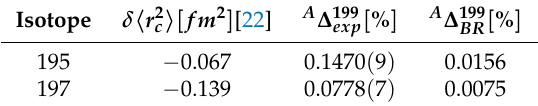
Table 10. Experimental HFA for I = 1/2 isotopes compared with the BR-anomaly.